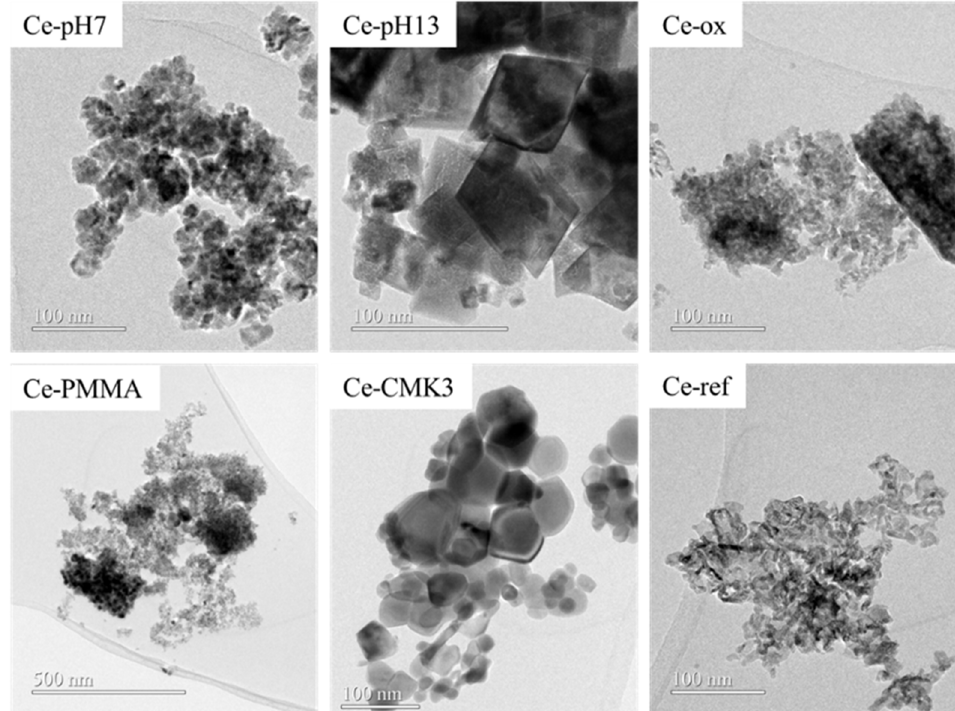
Figure 2. Representative low-magnification HRTEM images of the ceria